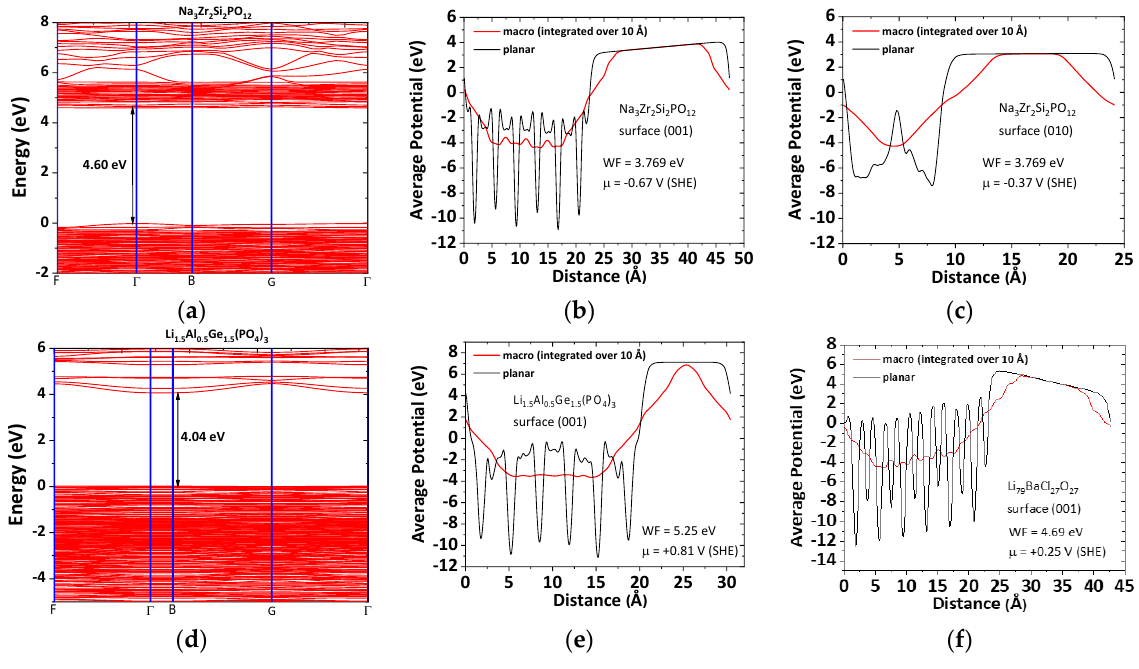
Figure 11. Ab initio : average potentials for solid electrolytes. The macro potentials correspond to integration over 10 Å; average potentials for (001) simulated surfaces and ( a ) electronic band structure of Na 3 Zr 2 Si 2 PO 12 showing a band gap of 4.60 eV, obtained for the bulk superstructure (P1) using DFT; ( b ) average potentials for the (001) and (010) simulated surfaces of Na 3 Zr 2 Si 2 PO 12 ; ( c ) electronic band structure of Li 1.5 Al 0.5 Ge 1.5 (PO 4 ) 3 showing a band gap of 4.04 eV, obtained for the bulk superstructure (P1) using DFT; average potentials for (001) simulated surface of ( d ) Na 3 Zr 2 Si 2 PO 12 ; ( e ) Li 1.5 Al 0.5 Ge 1.5 (PO 4 ) 3 ; ( f ) Li 2.99 Ba 0.005 ClO (Li 79 BaCl 27 O 27 ) Note: The (001) sur- face average potential for Al was obtained in [31]; the electronic band structures for Na 3 Zr 2 Si 2 PO 12 and Li 1.5 Al 0.5 Ge 1.5 (PO 4 ) 3 were calculated for triclinic (P1) as these phases are disordered, and there- fore have to be simulated in a superstructure although respecting atom positions, cell